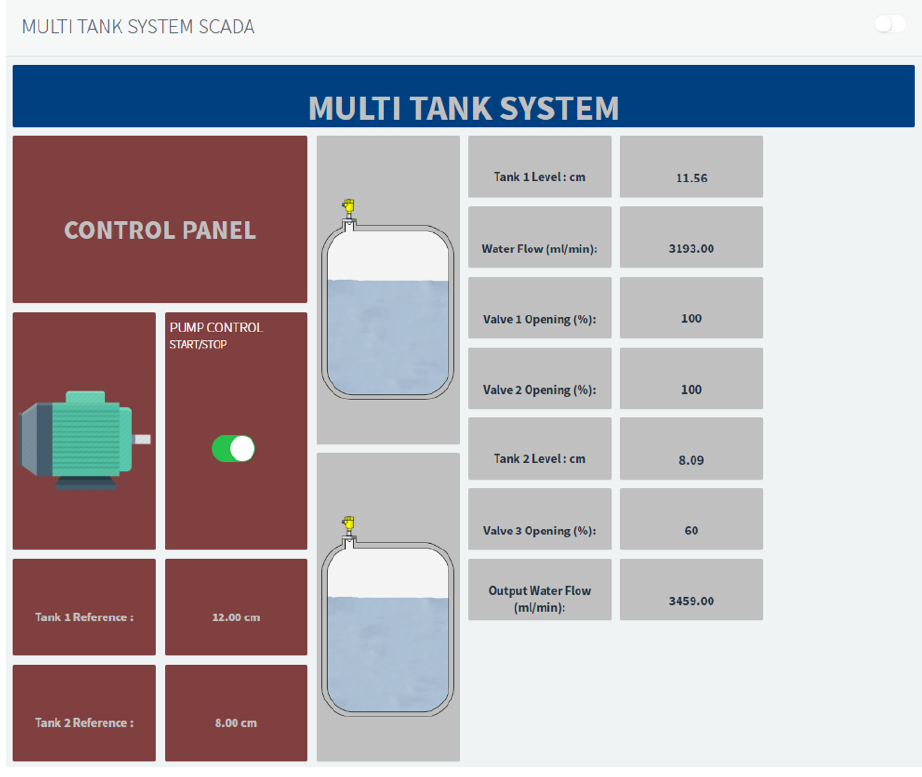
Figure 14. Dashboard of the IoT